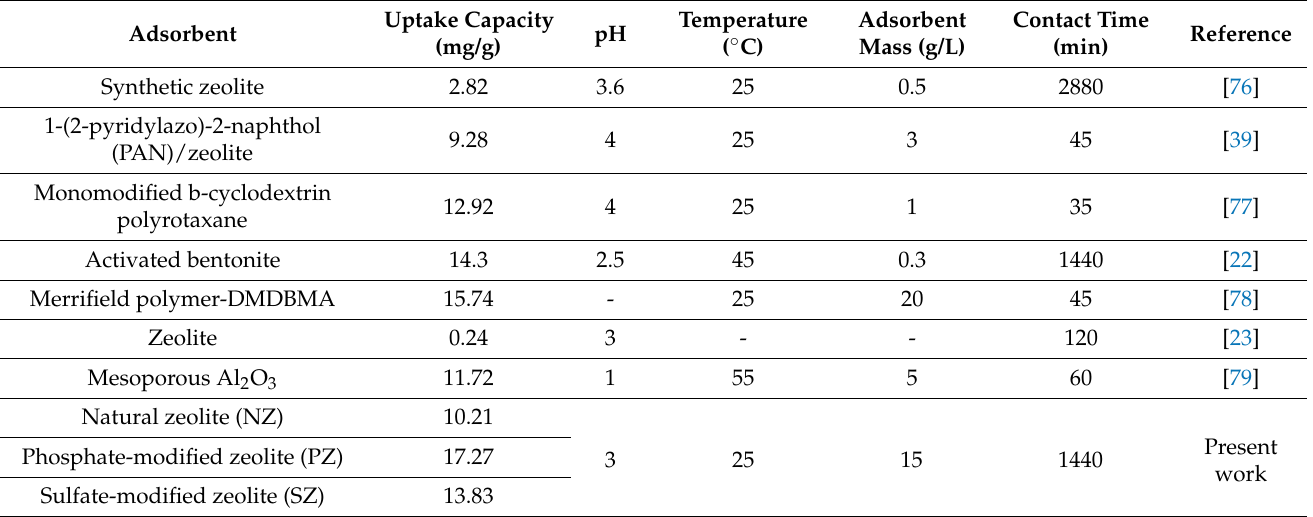
Table 6. Comparison of the maximum adsorption capacity of thorium onto PZ and SZ with various